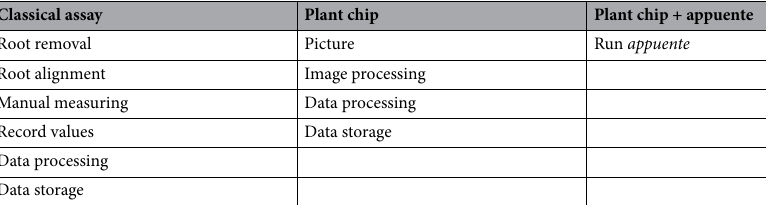
Table 2. Tasks required in each format of the root elongation assays: classical method on Petri dishes, original Plant chip device, and Plant chip combined with appuente . The listed tasks correspond to measurement and data gathering; the previous assay steps (seed positioning, working solutions, incubation) are common to all formats. In the simplest approach (see text for details) appuente requires manual pen